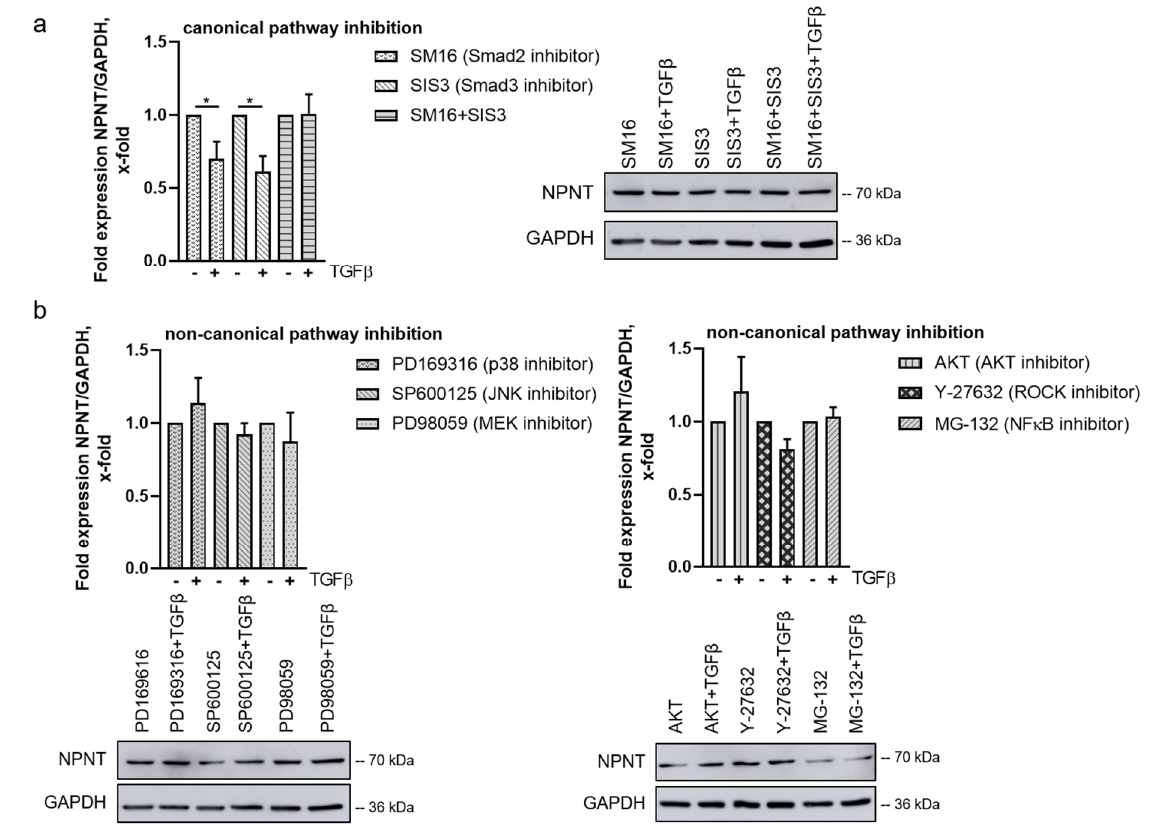
Figure 5. TGF- β -mediated downregulation of NPNT is dependent on the non-canonical signaling pathways in podocytes. ( a , b ) Western blot to determine NPNT protein expression in cultured human podocytes in the presence of ( a ) canonical (SM16 and SIS3) or ( b ) non-canonical (PD169316, SP600125, PD98059, AKT inhibitor, MG-132, and Y-27632) pathway inhibitors after stimulation with TGF- β . NPNT protein expression, normalized to GAPDH, is given as the change compared to stimulation with inhibitor without TGF- β . Representative Western blots are shown for each treatment. n = 5–6 independent experiments; * p < 0.05.